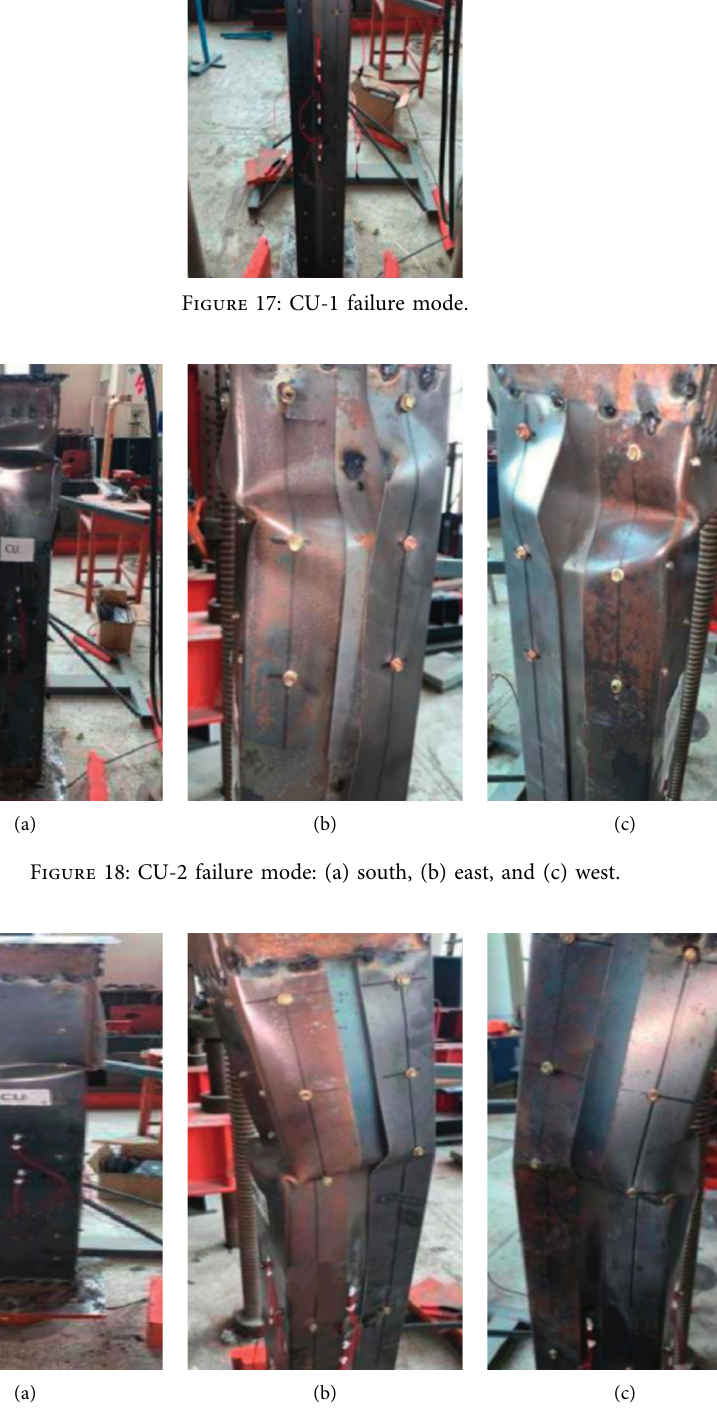
Figure 19: CU-3 failure mode: (a) south, (b) east, and (c) west.